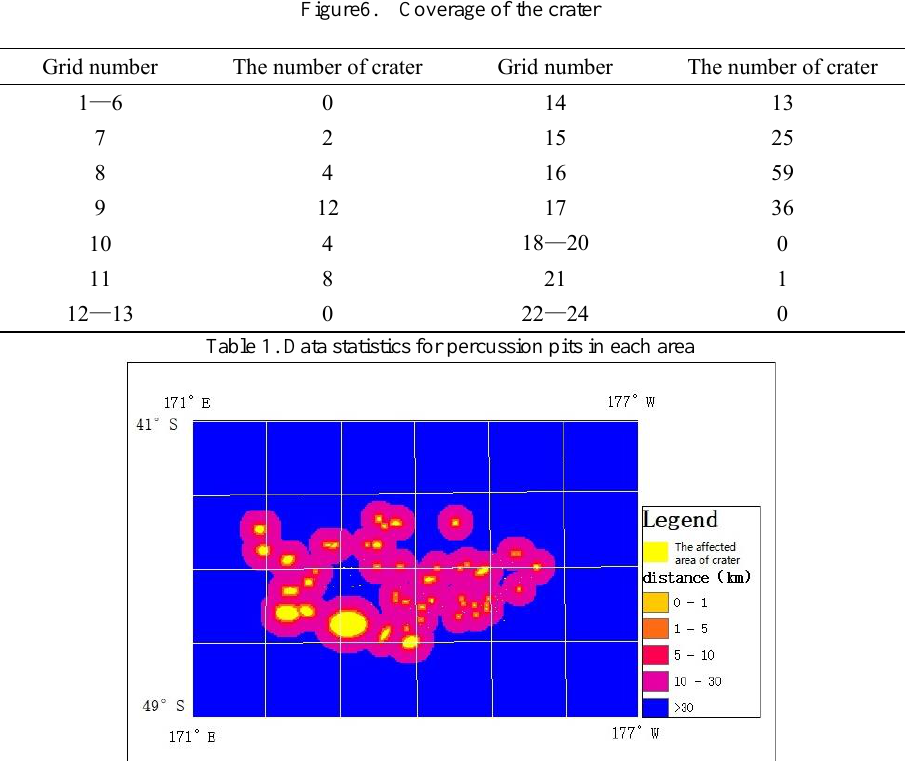
Figure6. Coverage of the crater